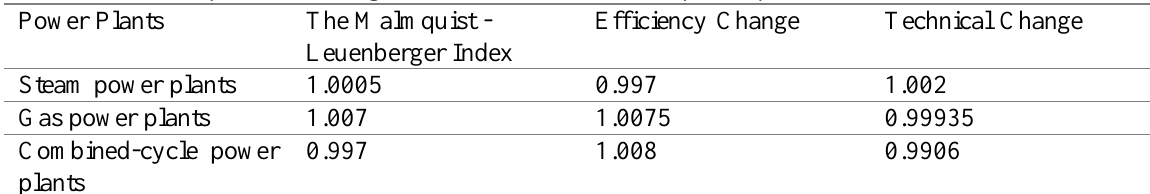
Table 4. The Malmquist -Leuenberger Index in Iranian combined-cycle power plants Power Plant